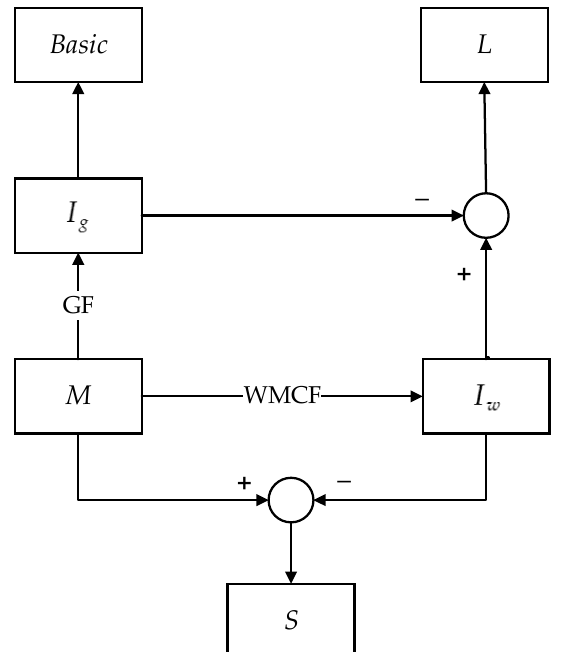
Figure 7. The flow chart of the multi-scale decomposition method based on WMCF and GF.